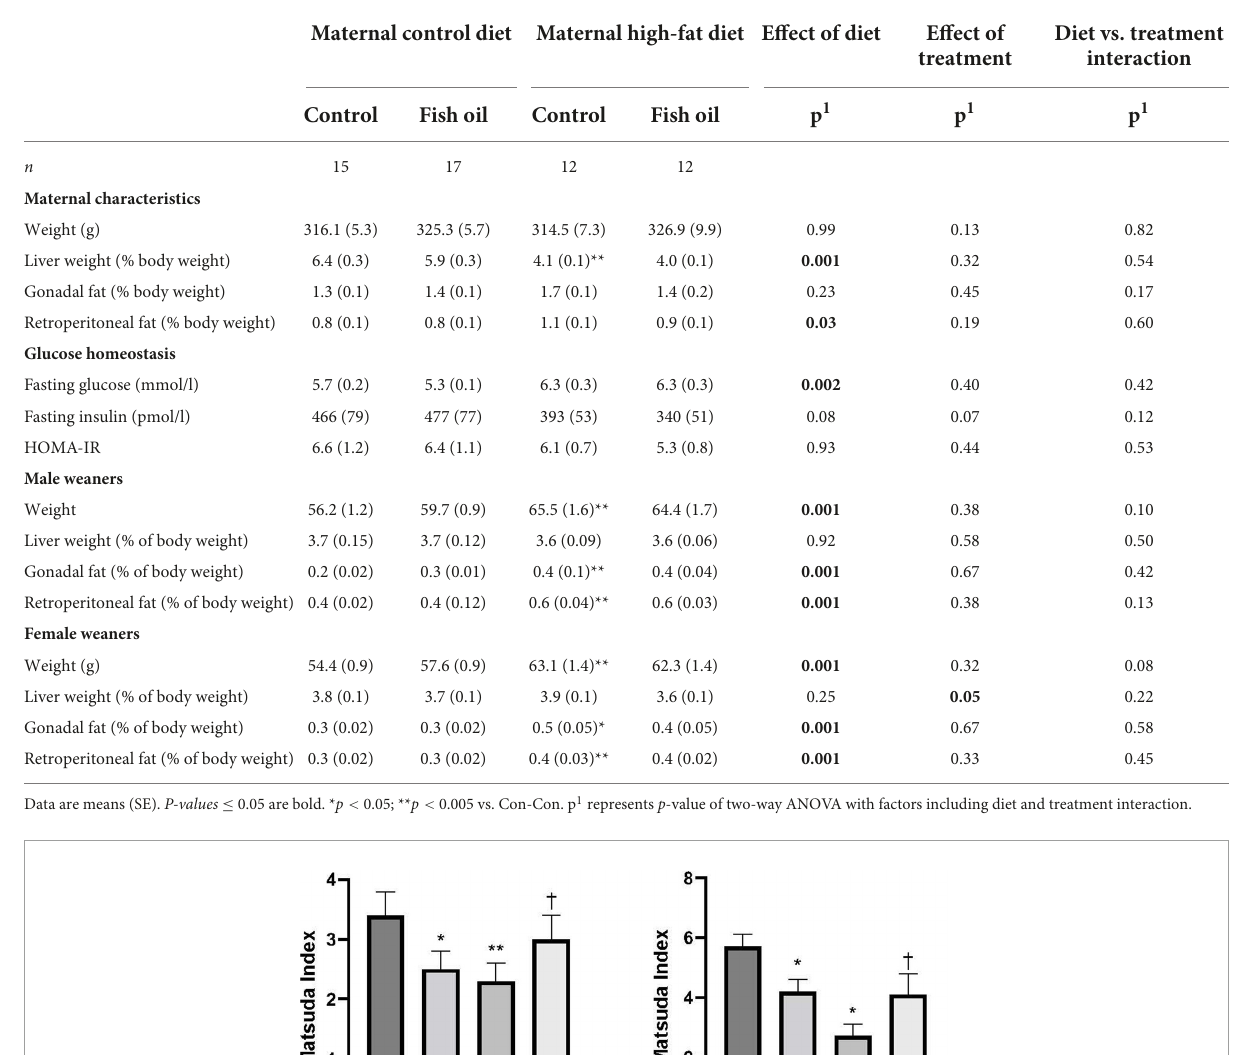
All outcomes were tested for normality (Shapiro-Wilk). Insulin and triglyceride concentrations were log-normalized prior to analysis. All outcomes were compared between groups using two-way ANOVA and post hoc comparisons using the Holm-Sidak’s correction, with maternal diet and